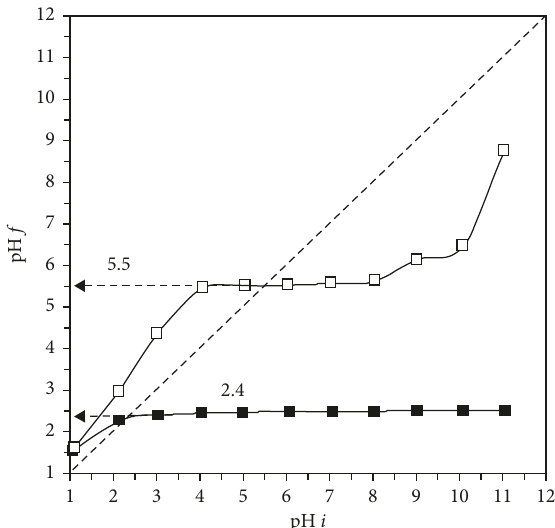
Figure 4: Point of zero charge of the adsorbents: bagasse ( □ ) and modified bagasse ( ■